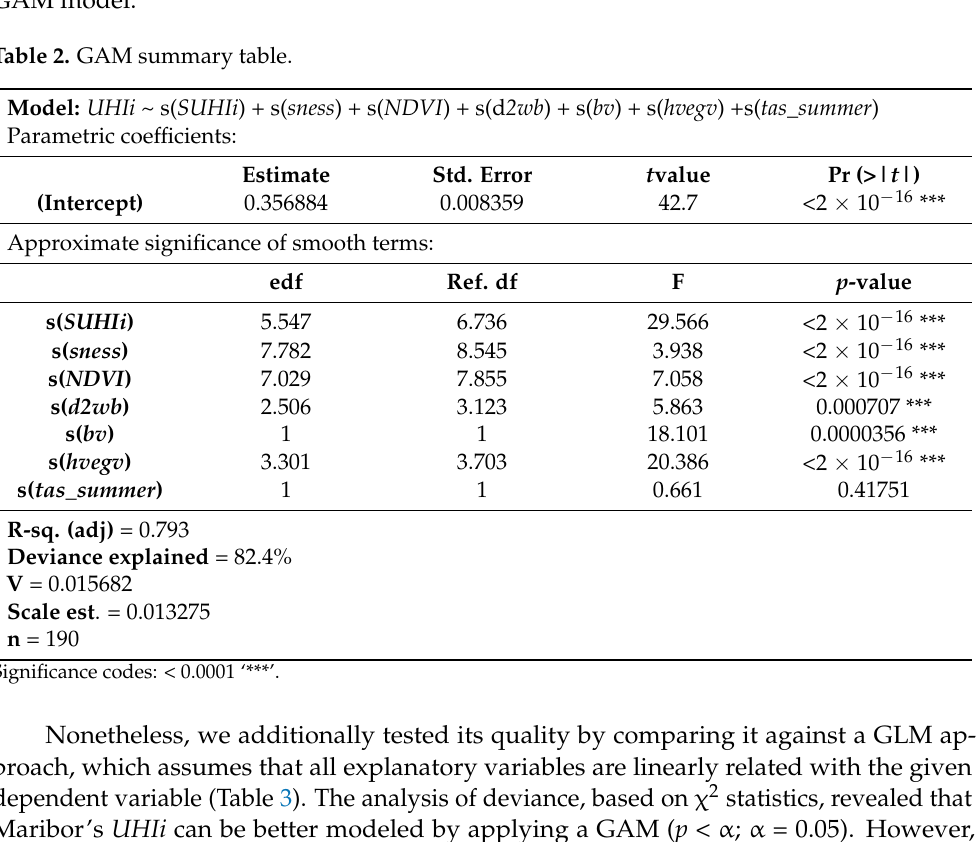
Table 2. GAM summary